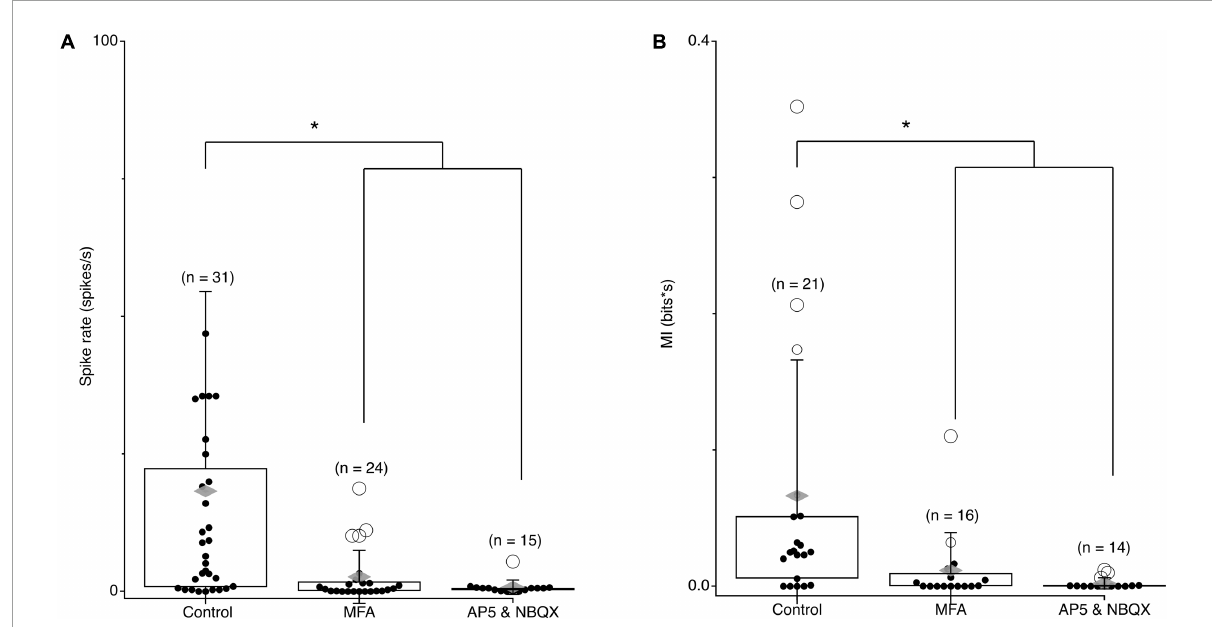
FIGURE7 Spontaneous MI between RGC pairs is blocked by gap junctions and excitatory synapses. (A) Average spontaneous firing rates for rd10 RGCs pairs in control conditions, 100 µ M MFA, and 50 µ m AP5 and 10 µ m NBQX. (B) Average spontaneous MI between rd10 RGC pairs in control conditions, 100 µ M MFA, and 50 µ M AP5 and 100 µ M NBQX. Filled black circles represent data points, open circles represent outliers, whiskers show 1 standard deviation, gray diamonds represent the mean. *Denotes p <